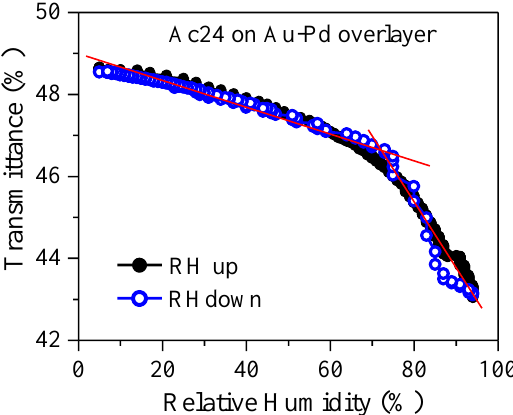
Figure 4 . Transmittance versus relative humidity curve for PVA film (80 nm thick) of 24% acetal content, deposited on Au–Pd (30nm) covered glass substrate, pre-annealed at 60 °C measured for increasing (solid black symbols) and decreasing (open blue symbols) humidity.